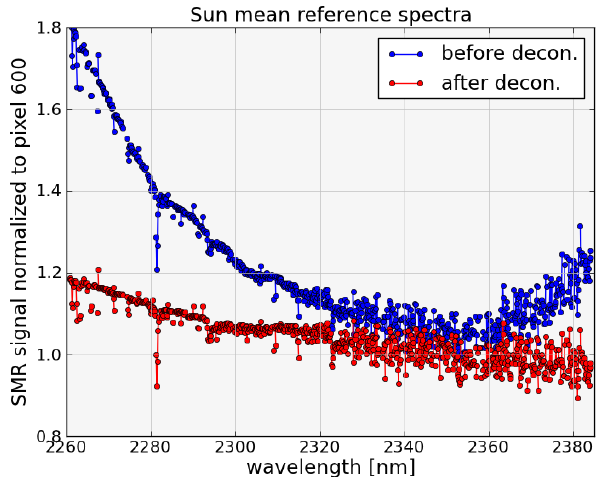
Fig. 7. Sun mean reference (SMR) spectrum in channel 8 with ice layer (blue) and with clean detector (red), normalised to the signal in an arbitrary pixel to illustrate the change in the spec- tral shape.